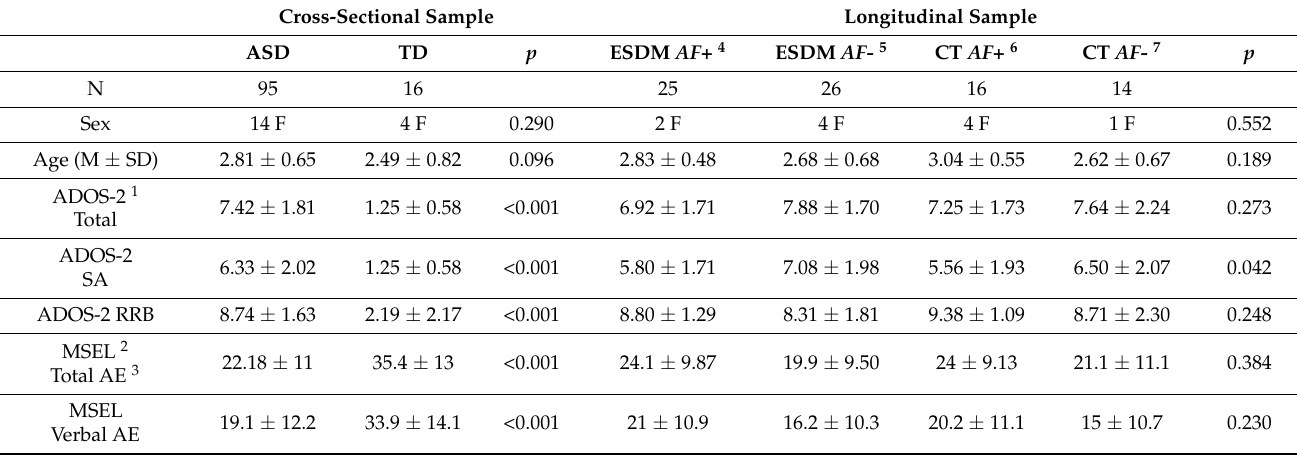
Table 1. Cross-sectional and longitudinal sample demographics at